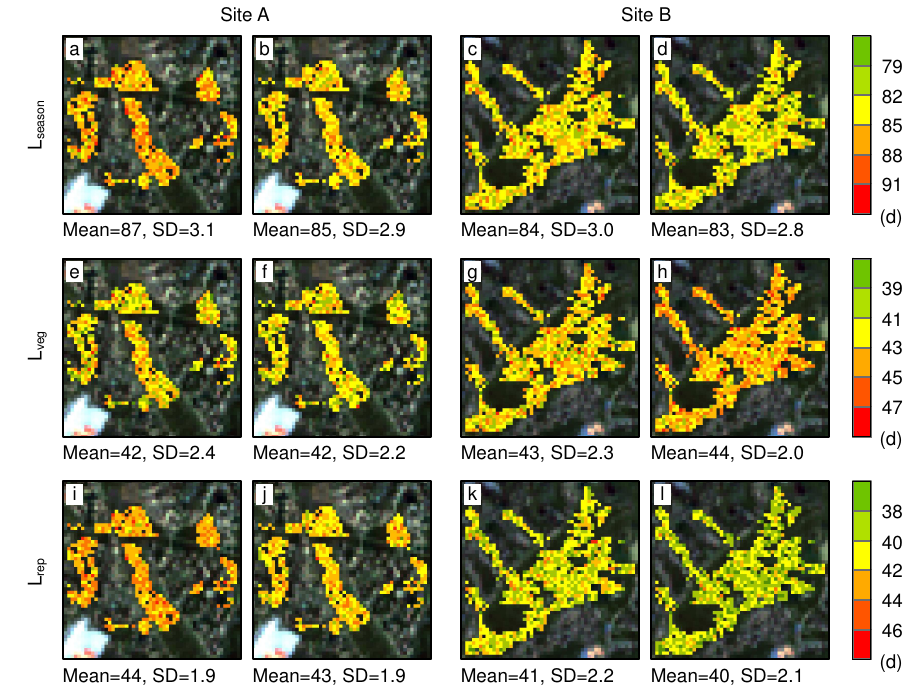
Figure 7. Spatial distributions of the mean lengths of growth season ( L season ) ( a – d ), vegetative phase ( L veg ) ( e – h ), and reproductive phase ( L rep ) ( i – l ) for Sites A and B during the period 2013–2017. Each of the phenometrics was derived from NDVI ( a , c , e , g , i , k ) and phase–space ( b , d , f , h , j , l